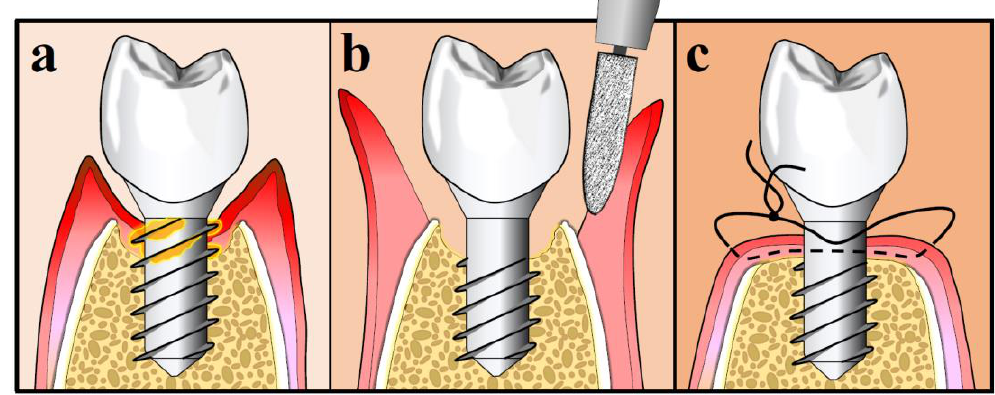
Figure 4. Apically position flap with implantoplasty: ( a ) Pre-operative; ( b ) Intra-operative; ( c ) Flap closure.